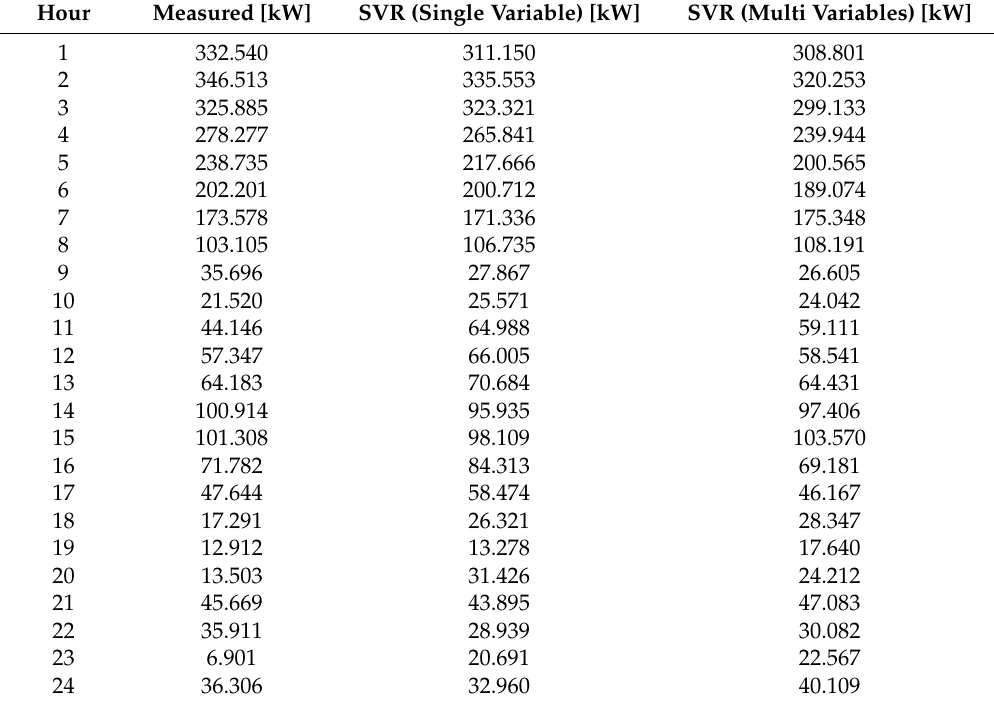
Table A4. Measured and forecasted wind power outputs to additional turbine on 8 January